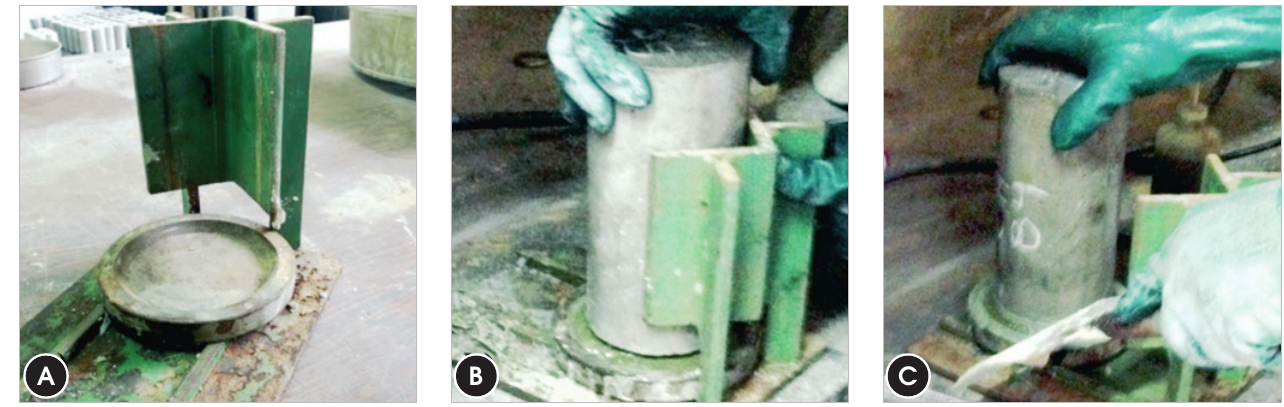
Alignment device used and application of sulfur mortar